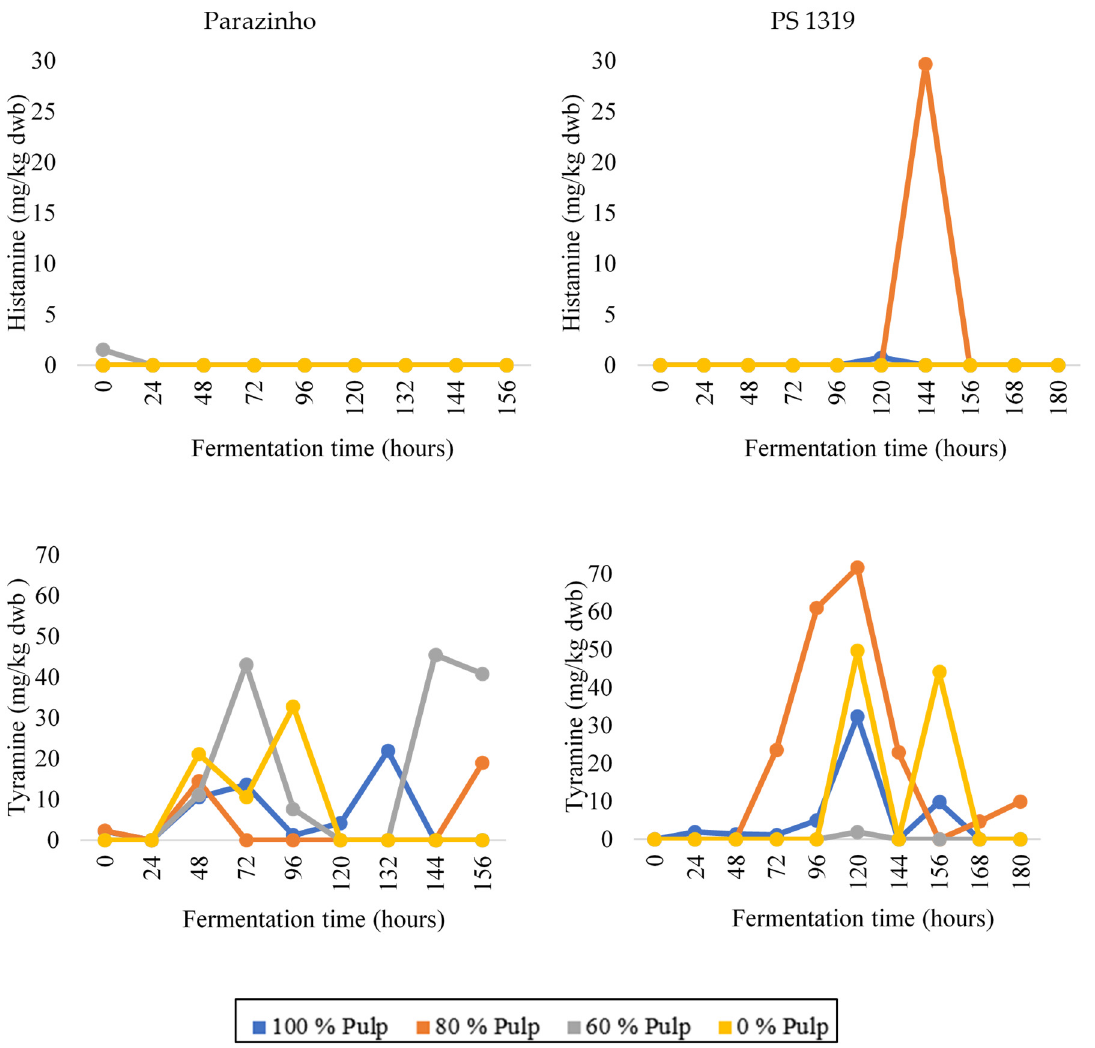
Figure 3. Changes in the levels of histamine and tyramine during on-farm fermentation of two varieties of cocoa (PS 1319 and Parazinho) from Bahia, Brazil, using different proportions of pulp (100, 80, 60, and 0%).